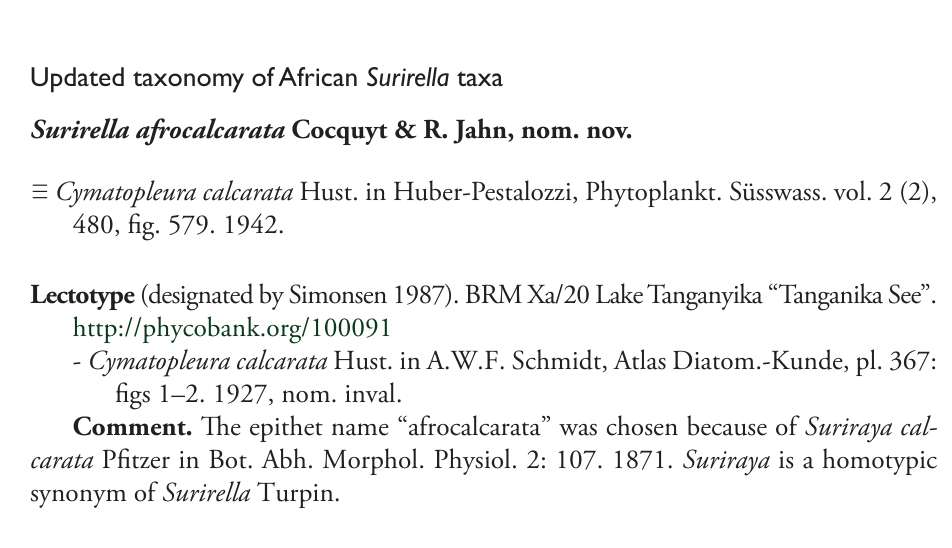
fig. 1D in Cocquyt and Jahn (2014) “Malawi, Lake Malombe, after the discharge of Lake